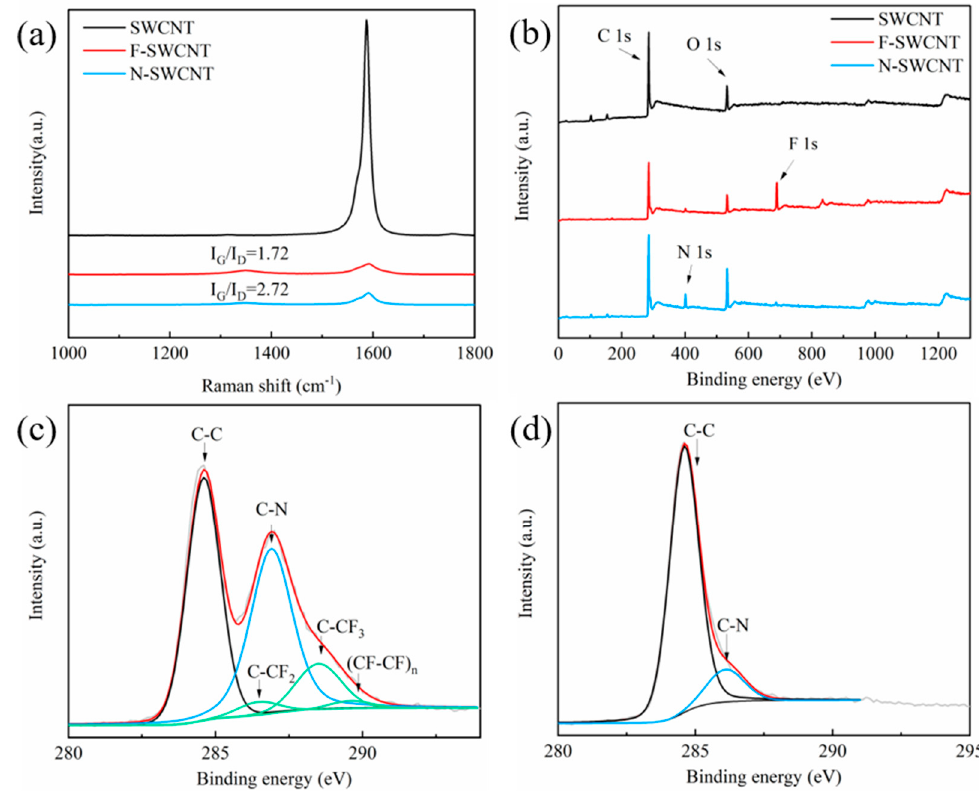
Figure 2. ( a ) Raman and ( b ) XPS spectra of SWCNT, F − SWCNT and N − SWCNT films. ( c ) C 1 s curves of the F − SWCNT film. ( d ) C 1 s curves of the N − SWCNT film.